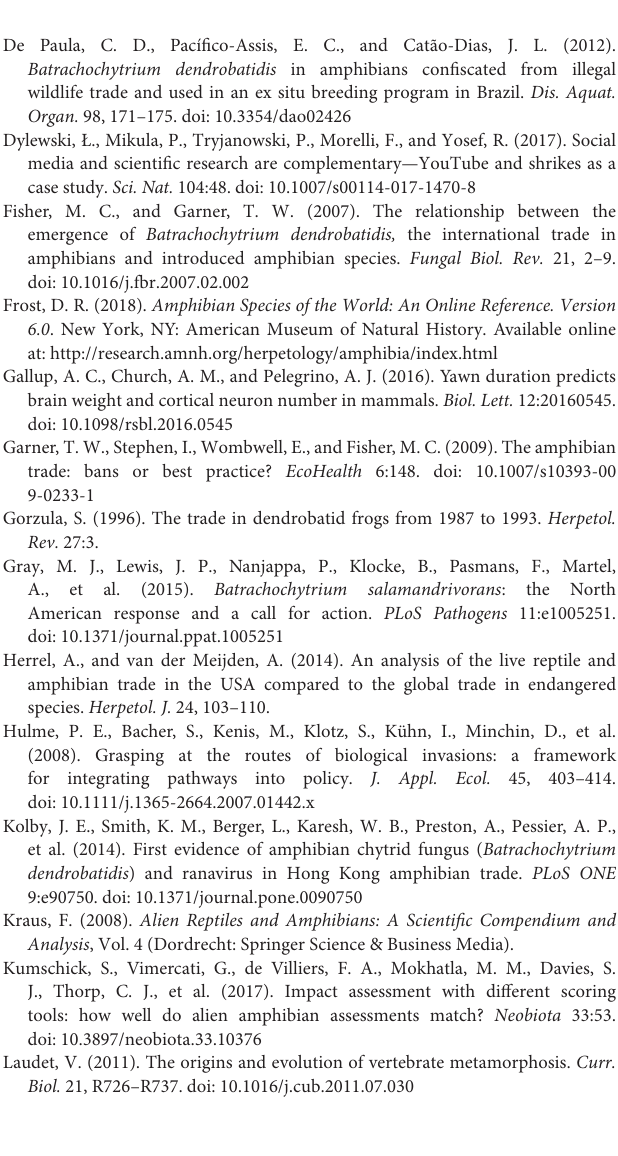
Supplementary Table 2 | Videos watched (URL), date posted, date accessed, and country of origin. Species are identified (with Order, Superfamily, Family and Species). Videos are divided into type and subdivided into